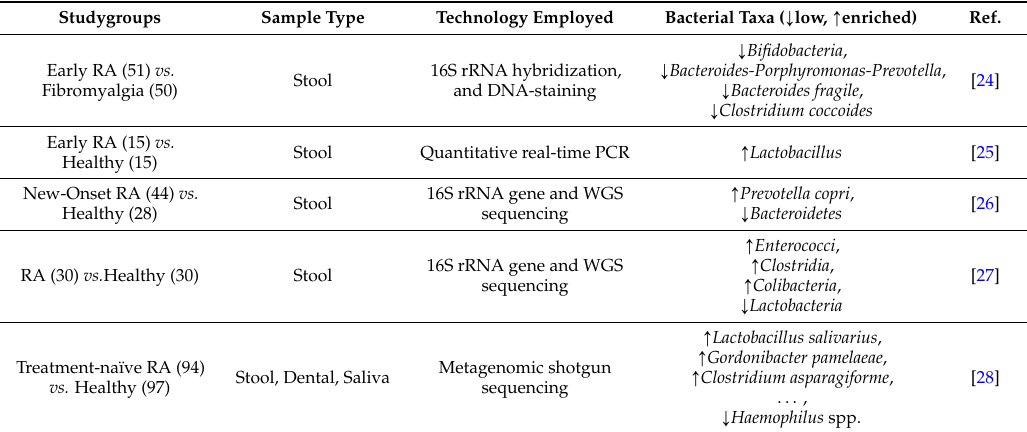
Table 1. Alterations of gut microbiota related with